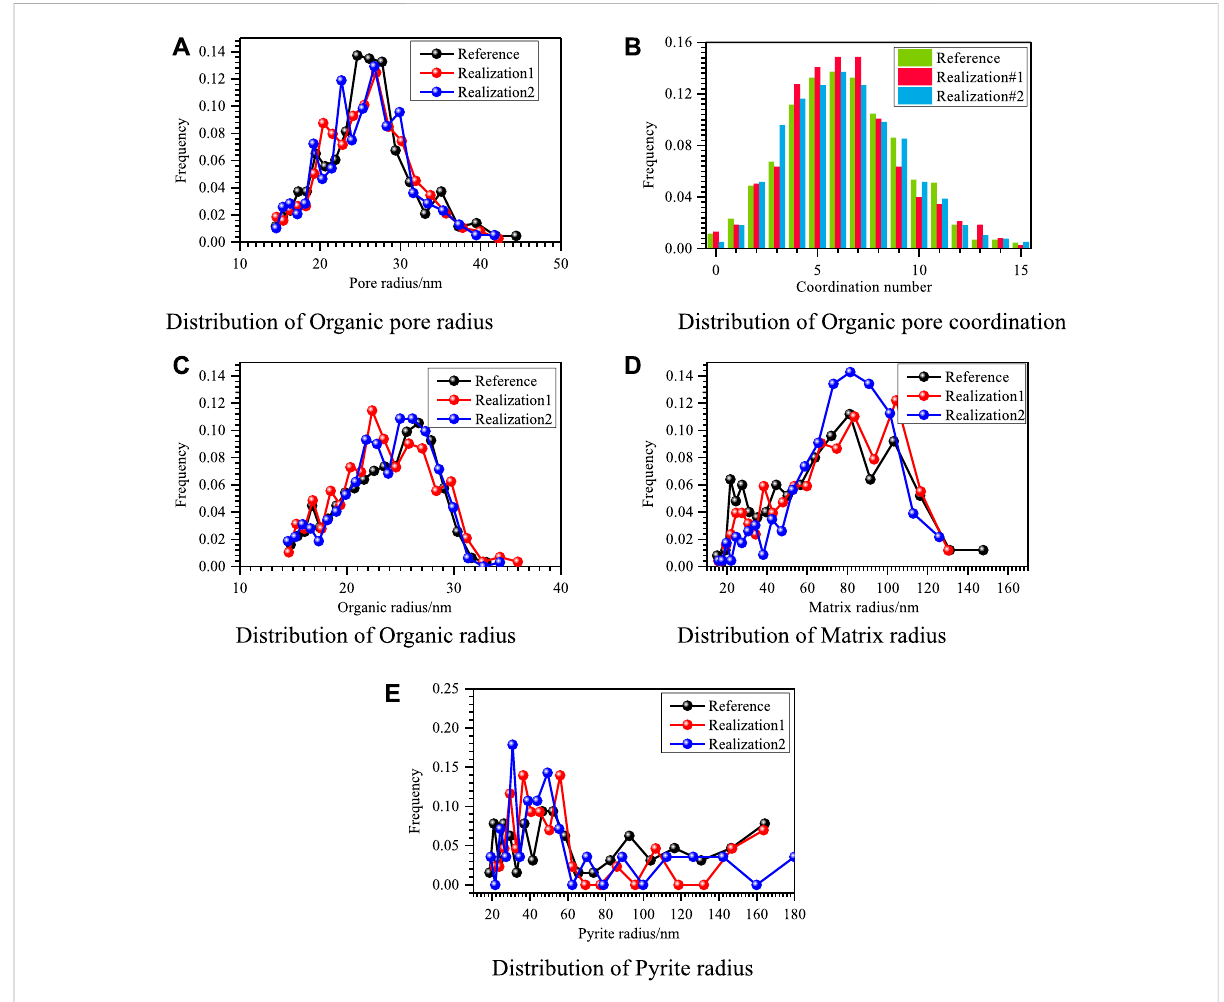
FIGURE 8 Comparison of pore structure distribution of the reference image and two realizations for different phases. (A) Distribution of organic pore radius, (B) distribution of organic pore coordination, (C) distribution of organic matter radius, (D) distribution of matrix radius, and (E) distribution of pyrite